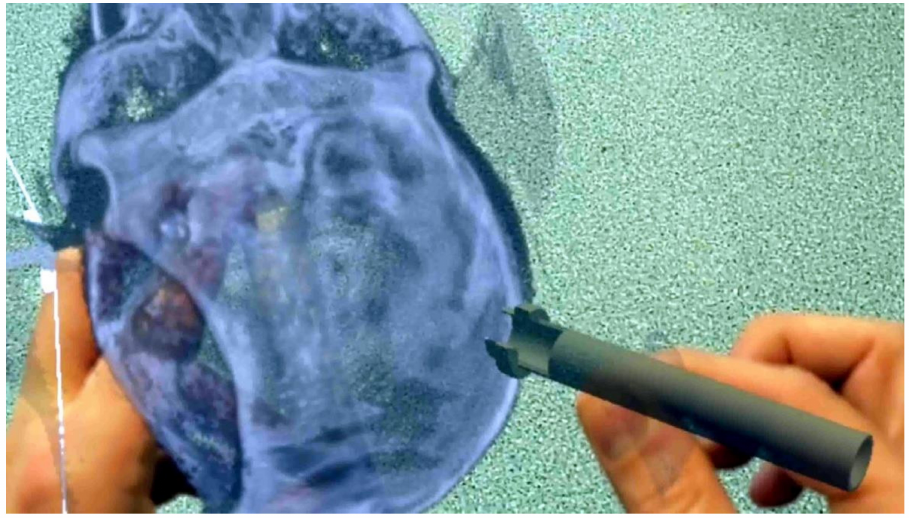
Figure 1. Application of VR for teaching placement of bed side ICP monitor via an external ventricu- lar